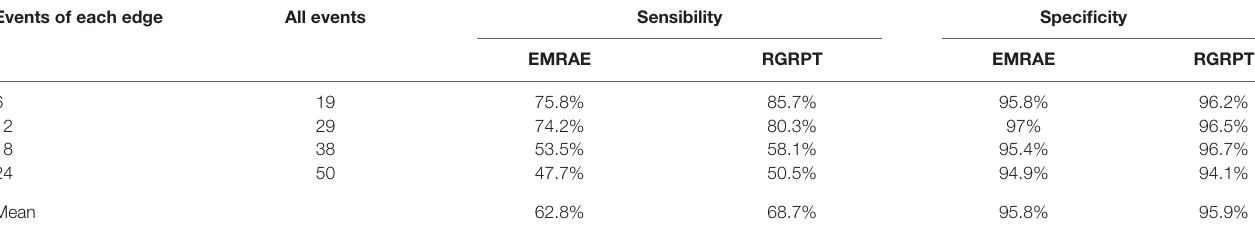
TABLE 2 | Results of EMRAE and recovering the genome rearrangements based on phylogenetic tree algorithms in predicting all events. Events of each edge